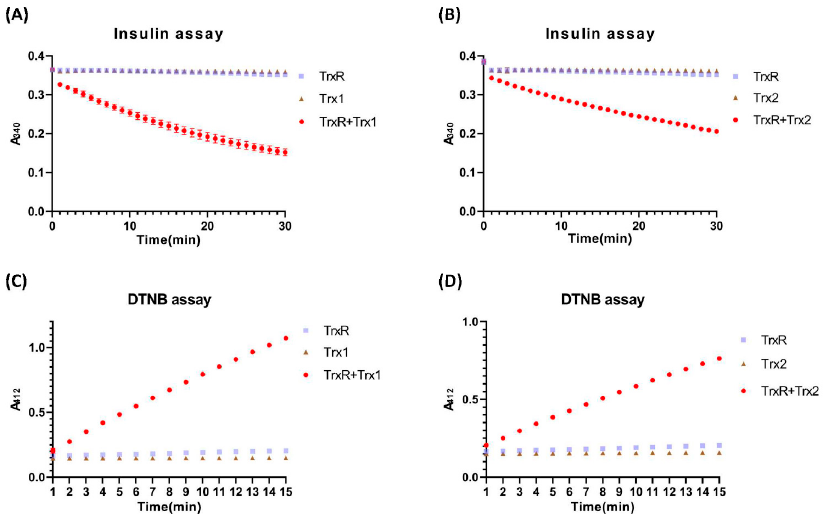
Figure 2. Reduction of insulin and DTNB by DrTrx1 and DrTrx2. Reduction of insulin by DrTrx1 (0.1 μ M) ( A ) and DrTrx2 (0.5 μ M) ( B ) coupled to the DrTrxR/NADPH regeneration system. Negative controls were represented by the omission of DrTrxR in the presence of each Trx protein or omission of Trx protein in the presence of DrTrxR. Reduction of DTNB by DrTrx1 (0.1 μ M) ( C ) and DrTrx2 (0.5 μ M) ( D ) coupled to the DrTrxR/NADPH regeneration system. Negative controls are represented by the omission of DrTrxR in the presence of each Trx protein or omission of Trx protein in the presence of DrTrxR. Reduction of insulin ( A , B ) was recorded by measuring the decrease in NADPH oxidation at 340 nm. Reduction of DTNB was recorded as an increase in absorption at 412 nm ( C , D ). Error bars indicate the standard deviation for three experimental replicates.